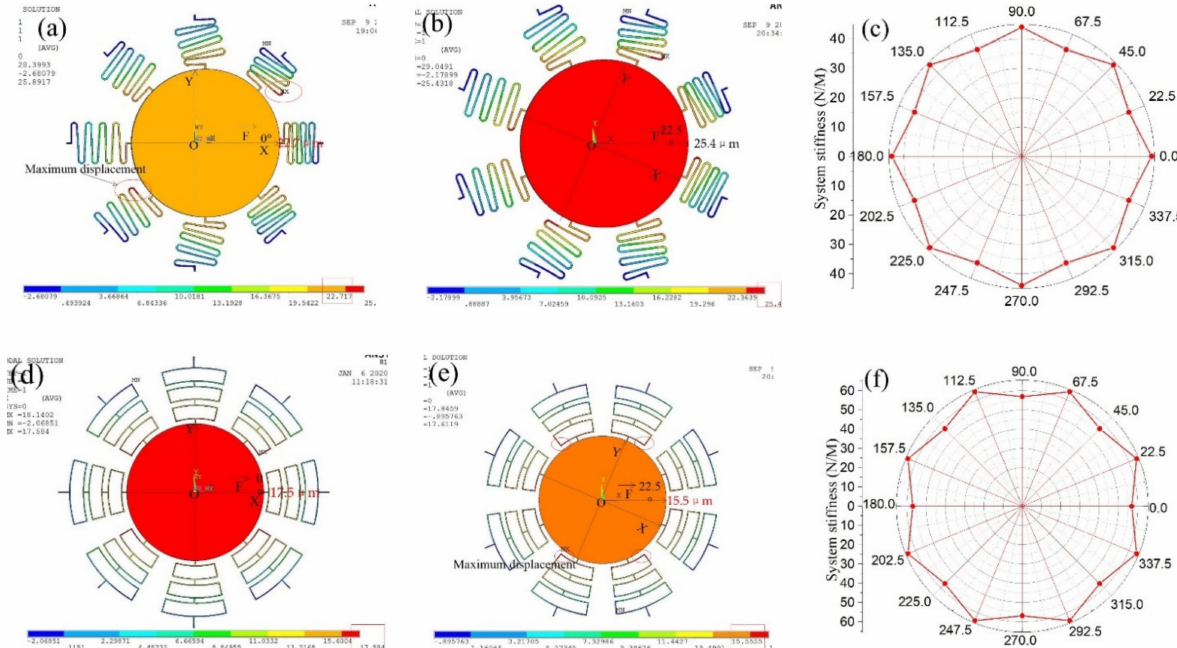
Figure 2. ( a ) Displacement distribution of suspension system when the force is applied in the x-direction. ( b ) Displacement distribution of suspension system with S-springs when the force is applied in the direction of 22.5 degrees. ( c ) The stiffness distribution of suspension system with S-shaped. ( d ) Displacement distribution of suspension system when the force is applied in the x-direction. ( e ) Displacement distribution of suspension system with rectangular springs when the force is applied in the direction of 22.5 degrees. ( f ) The stiffness distribution of suspension system with rectangular